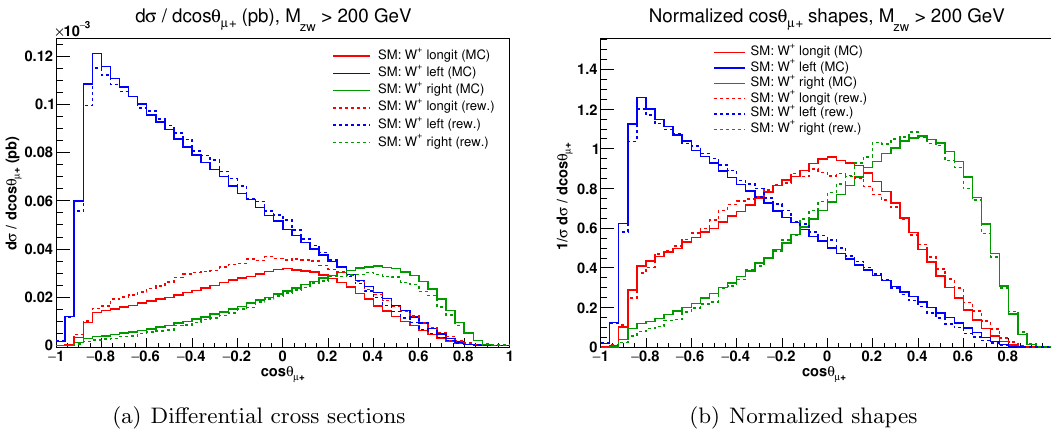
Figure 9 . W + Z scattering: polarized cos (cid:18) distributions in the region M WZ > 200 GeV. Results (cid:22) + of the reweighting procedure compared with results of the MC calculation with polarized amplitudes. The full set of cuts and neutrino reconstruction are